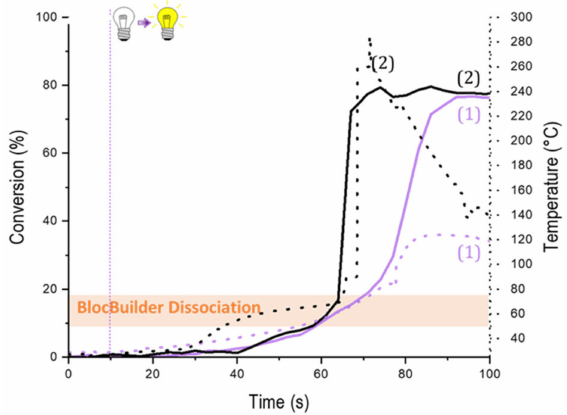
Figure 13. Simultaneous RT-FTIR / thermal imaging photopolymerization follow-ups (C = C conversion vs. irradiation time and temperature vs. irradiation time; 1.4 mm sample) under air upon LED@405 nm irradiation in the presence of Napht (0.1 wt.%), Ar 2 I + PF 6 − (1.5 wt.%), 4-dppba (0.5 wt.%), and Blocbuilder ® -MA (2 wt.%); in (1) Mix-MA; (2) TMPTA; the irradiation starts after 10